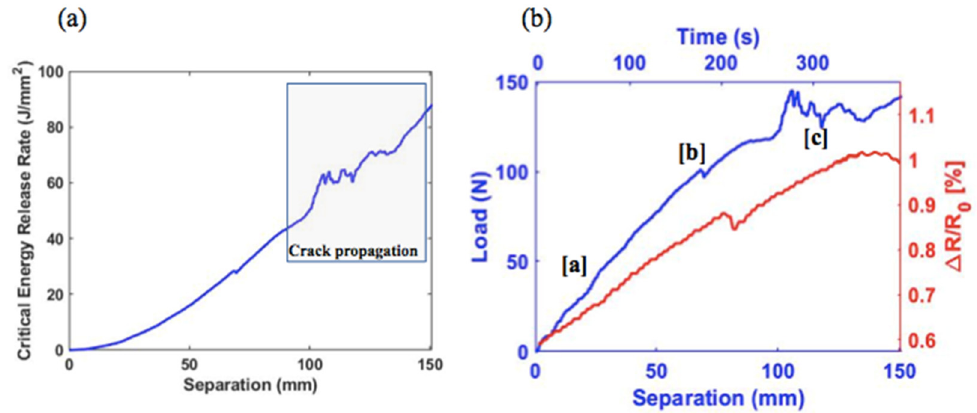
Figure 11. GFRP-SWCNT composite ( a ) mode I critical energy release rate, ( b ) mode I fracture propagation and percentage of resistance change where the slight charge release is labeled as [a]; upon further loading, crack propagates and more charge release was observed at both sections [b] and [c].